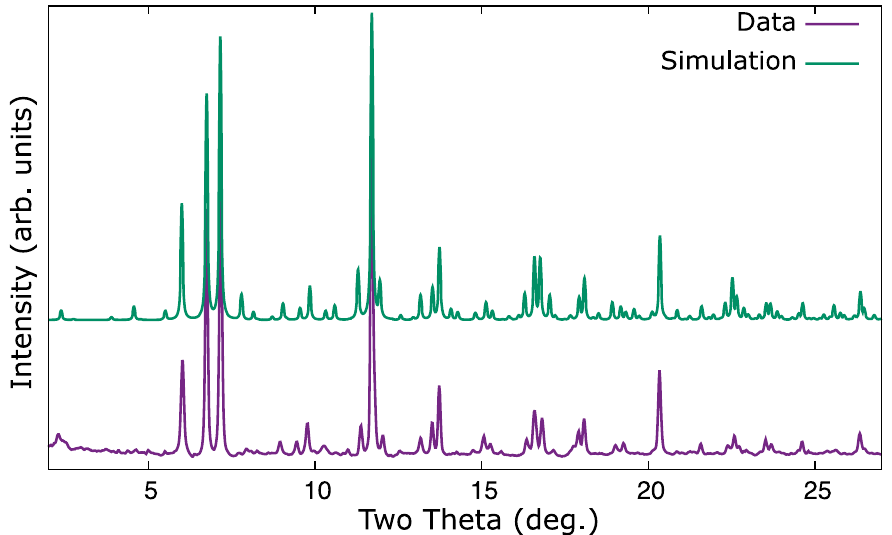
Figure 4. Comparison of observed data from a lithium–palladium mixture at 8.64 GPa (lower trace) and a ¯ 43 m Li simulated powder pattern (upper trace) of F 17 Pd 4 using the atomic parameters from Li 17 Sn 4 27 and lattice parameter and radiation from this study. The similarity supports the novel palladium–lithium compound having a similar structure to Li 17 Sn 4 .